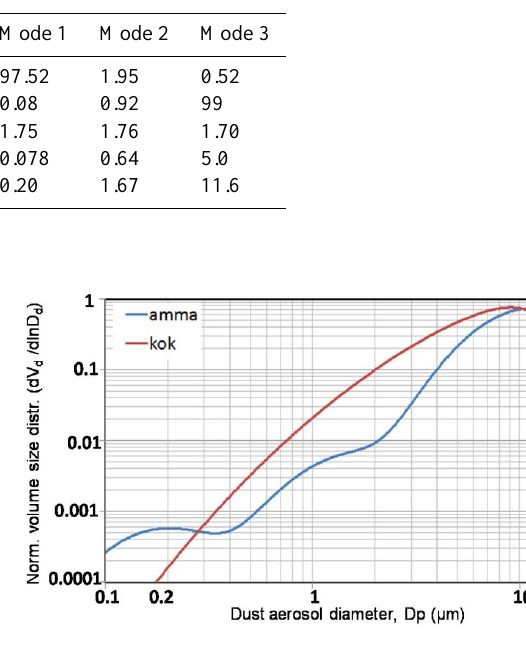
Fig. 6. Normalized volume size distribution of emitted dust aerosol given by AMMA distribution (blue line) and Kok theory (red line). 4